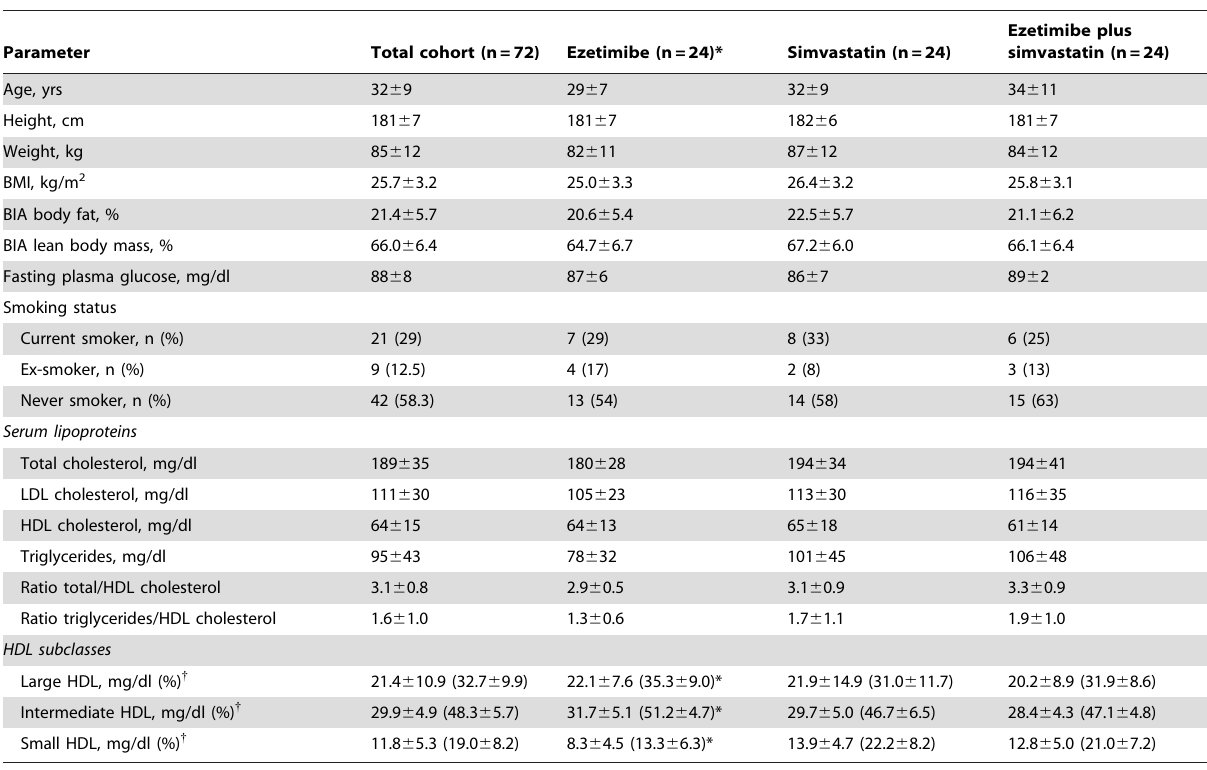
Table 1. Demographic data and biochemical baseline characteristics of the study